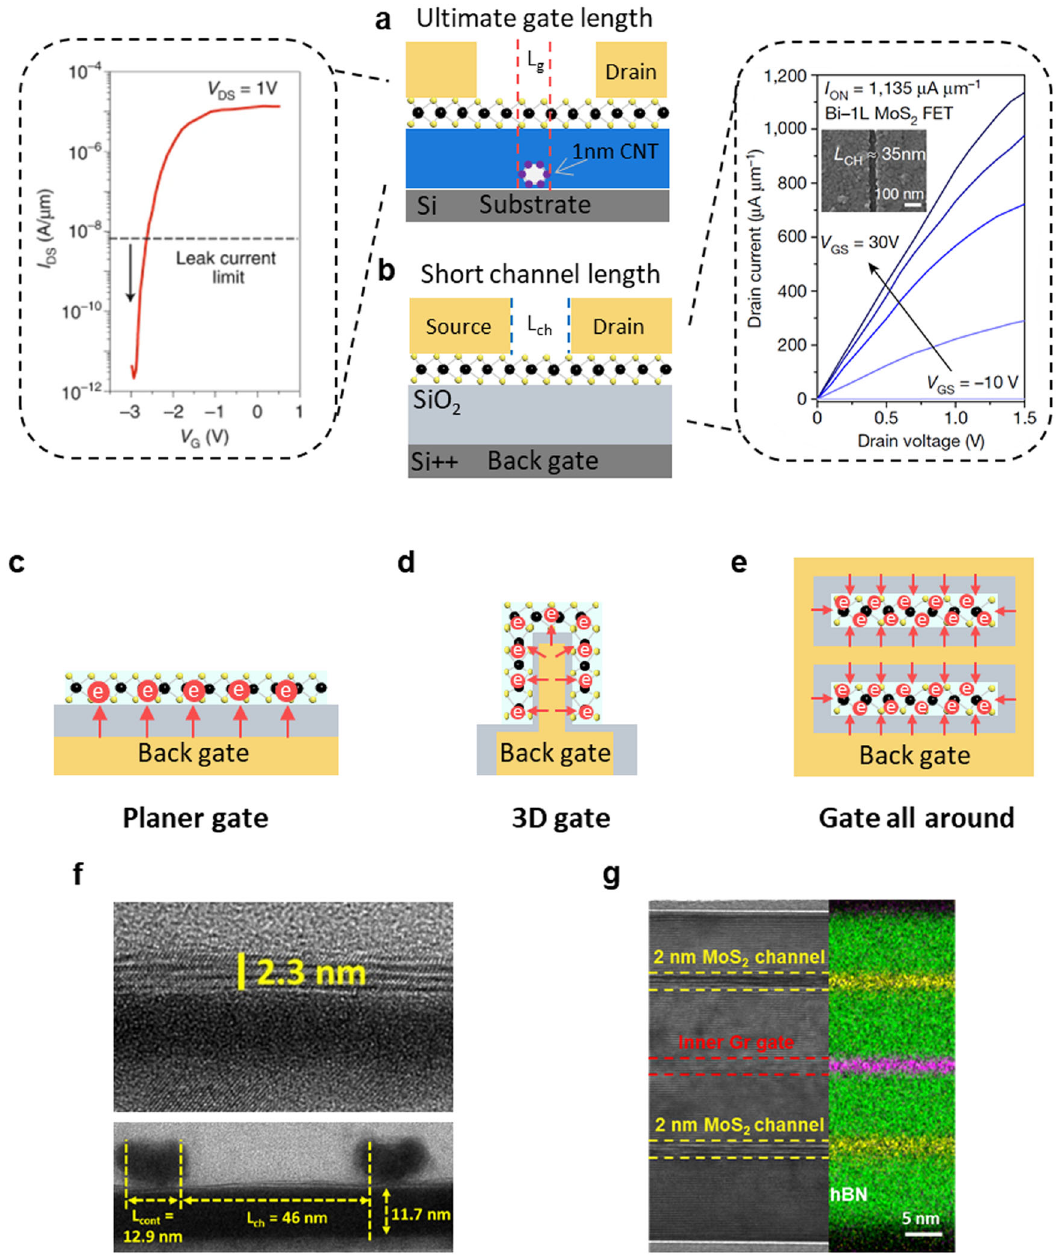
Fig. 3 Channel characteristics of 2D semiconductors. a Schematic illustrations of the 1 nm-gate-length CNT-MoS 2 transistor. The left panel shows the transfer characteristics curve of the 1 nm-gate-length device. The left and right panels are reproduced from ref. 33 and ref. 36 , respectively. b Schematic illustrations of the short-channel-length monolayer MoS 2 transistor. The right panel shows the output characteristics curves of the 35 nm-channel-length device. c – e Gate structure of 2D semiconductor and electric fi eld distribution including planer gate, 3D gate, and Gate all around. f , g Cross-sectional transmission electron microscope images refer to planer gate, 3D Gate all around. f , g are reproduced from refs. 37,39